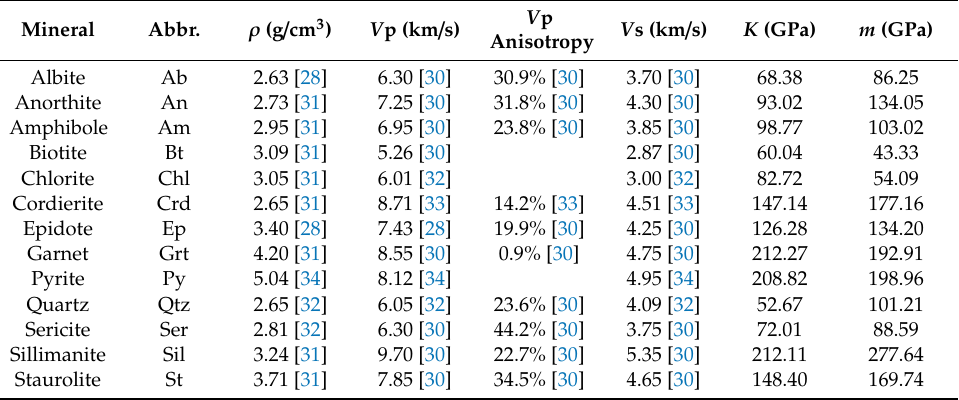
Figure 8. Summary of SEM-EDS analyses of high P-wave velocity minerals ( V p > 7.5 km) from samples of the hydrothermal alteration zone. ( a ) Volume fractions of high V p minerals; ( b ) scatter plot showing the relationship between cordierite abundance and P-wave velocity. Table 4. Seismic mineral properties.